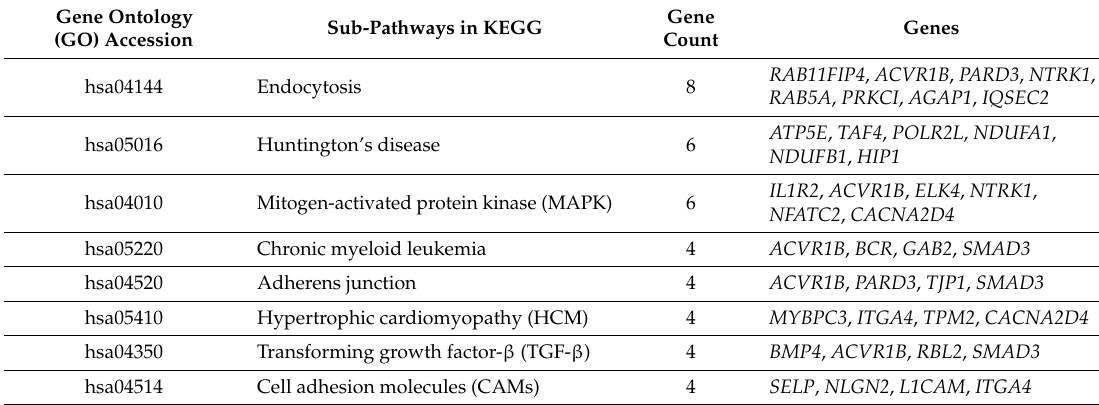
resistant and susceptible